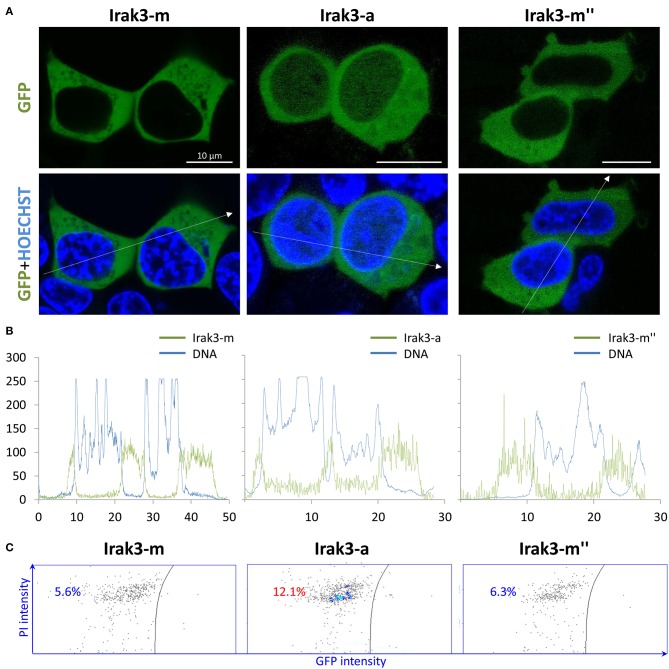
Overexpression of full-length factor Irak3 m and variants a, and m″ in HEK-293 cells. (A) Human HEK-293 cells were transfected with plasmids expressing the GFP-tagged Irak3 variants, the full-length factor m, truncated factor a, and splice variant m″. Cells were visualized 24 h after transfection with a confocal laser-scanning microscope. Nuclei were stained with Hoechst 33342 (blue). Scale bars represent 10 μm in all images. (B) Profile of fluorescence intensities (ordinate) recorded at specific locations (abscissa) across the cell following that path as indicated by the dotted arrows in 4A. (C) Live/dead assay of HEK-293 cells quantified the proportion of dead cells in the total cell count after the overexpression of full-length Irak3-m, truncated Irak3-a or spliced Irak3-m″ factors. The left part of each of the three dot plots shows the number of dead (PI-stained) GFP-negative cells and the right part shows the number of living GFP-positive (irak3-expressing) cells. One representative result is shown.